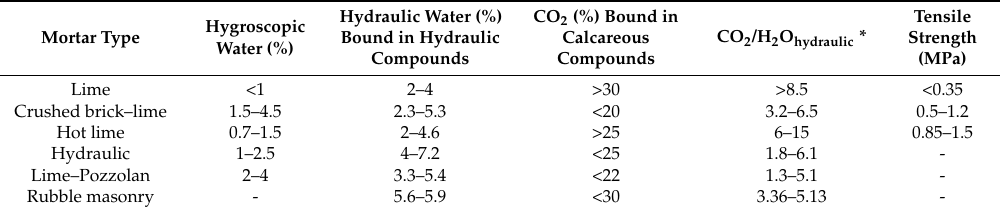
Table 7. Range of acceptability limits for different types of restoration mortars through thermal analysis results (TG/DTA) (physicochemical compatibility) and tensile strength measurements (mechanical compatibility) [233].